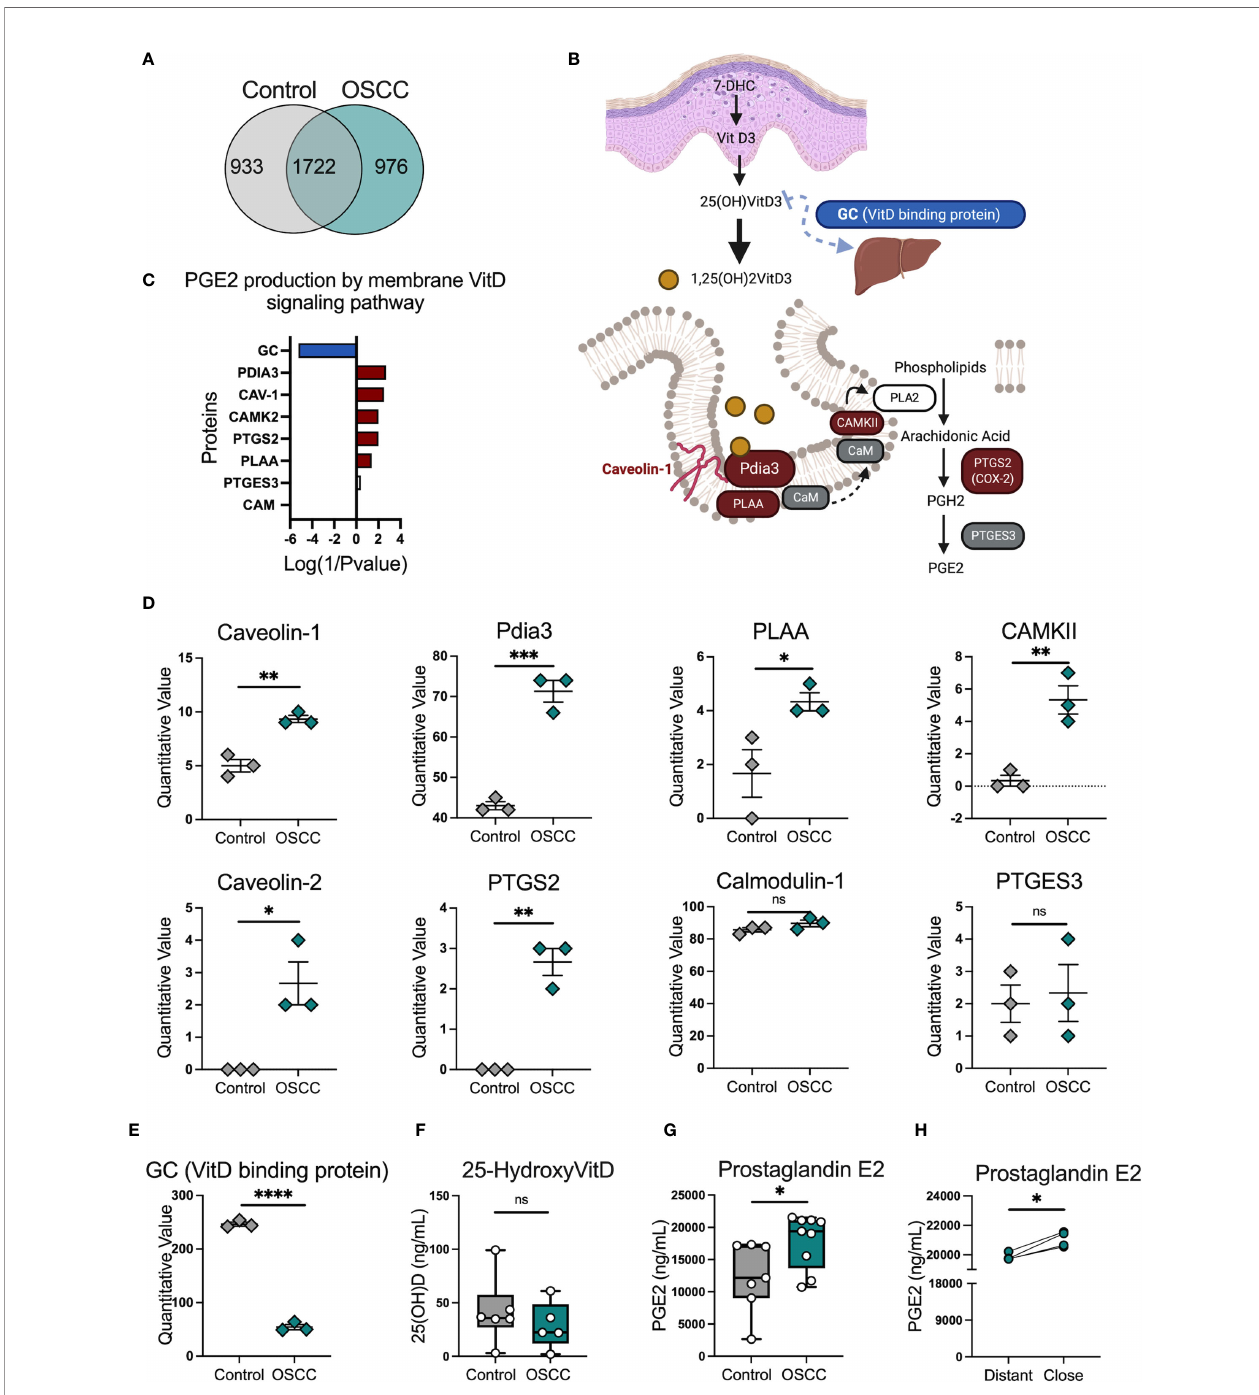
FIGURE 6 | Proteomic analysis identi fi ed several proteins related with the PGE2 production by membrane vitamin D signaling pathway in OSCC secretomes. (A) Venn diagram of unique and common proteins identi fi ed in secretome obtained from biopsies from 5 OSCC and 5 control samples using timsTOF Pro. (B) Proteins and (C) diagram of the PGE2 production by membrane vitamin D signaling pathway. Brie fl y, overexpressed proteins in OSCC were colored in red, reduced proteins in OSCC were colored in blue and proteins present in the secretomes but with no statistical difference between control and OSCC were colored in grey. (D) Quantitative values of proteins from the PGE2 production by membrane vitamin D signaling pathway, data are presented as mean ± SEM using scatter dot plots (Unpaired t test). (E) Quantitative values of vitamin D binding protein or GC, data are presented as mean ± SEM using scatter dot plots (Unpaired t test). (F) Levels of 25(OH)VitD and (G) PGE2 were compared between cancer and control secretomes, data are presented as mean ± SEM using bars with scatter dot plots (Unpaired t test). (H) Levels of PGE2 were measured in secretomes from distant and close OSCC biopsies to the tumor site, data is presented with individual symbols with paired lines (Paired t test). For all statistical tests, ∗∗∗∗ p < 0.0001, ∗∗∗ p < 0.001, ∗∗ p < 0.01 and ∗ p < 0.05 were considered signi fi cant. ns, not signi fi